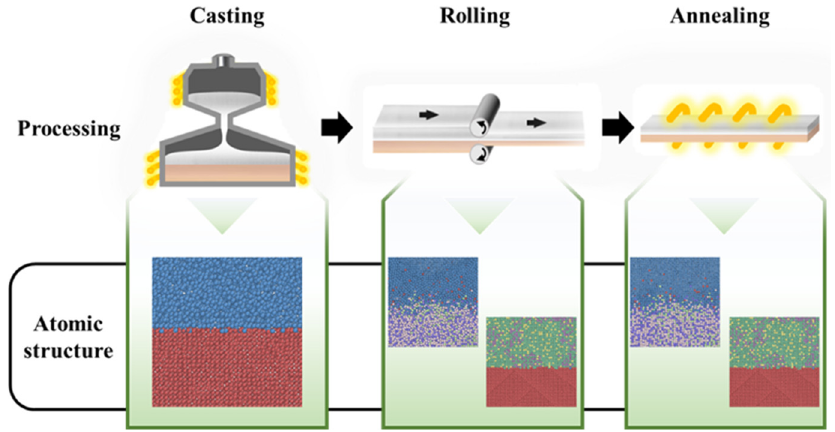
Figure 1. The sketch of Al–Cu cast rolling processing (including casting, cooling and rolling, and annealing) and corresponding atomic structures (including Al, Cu, and intermetallic compounds).